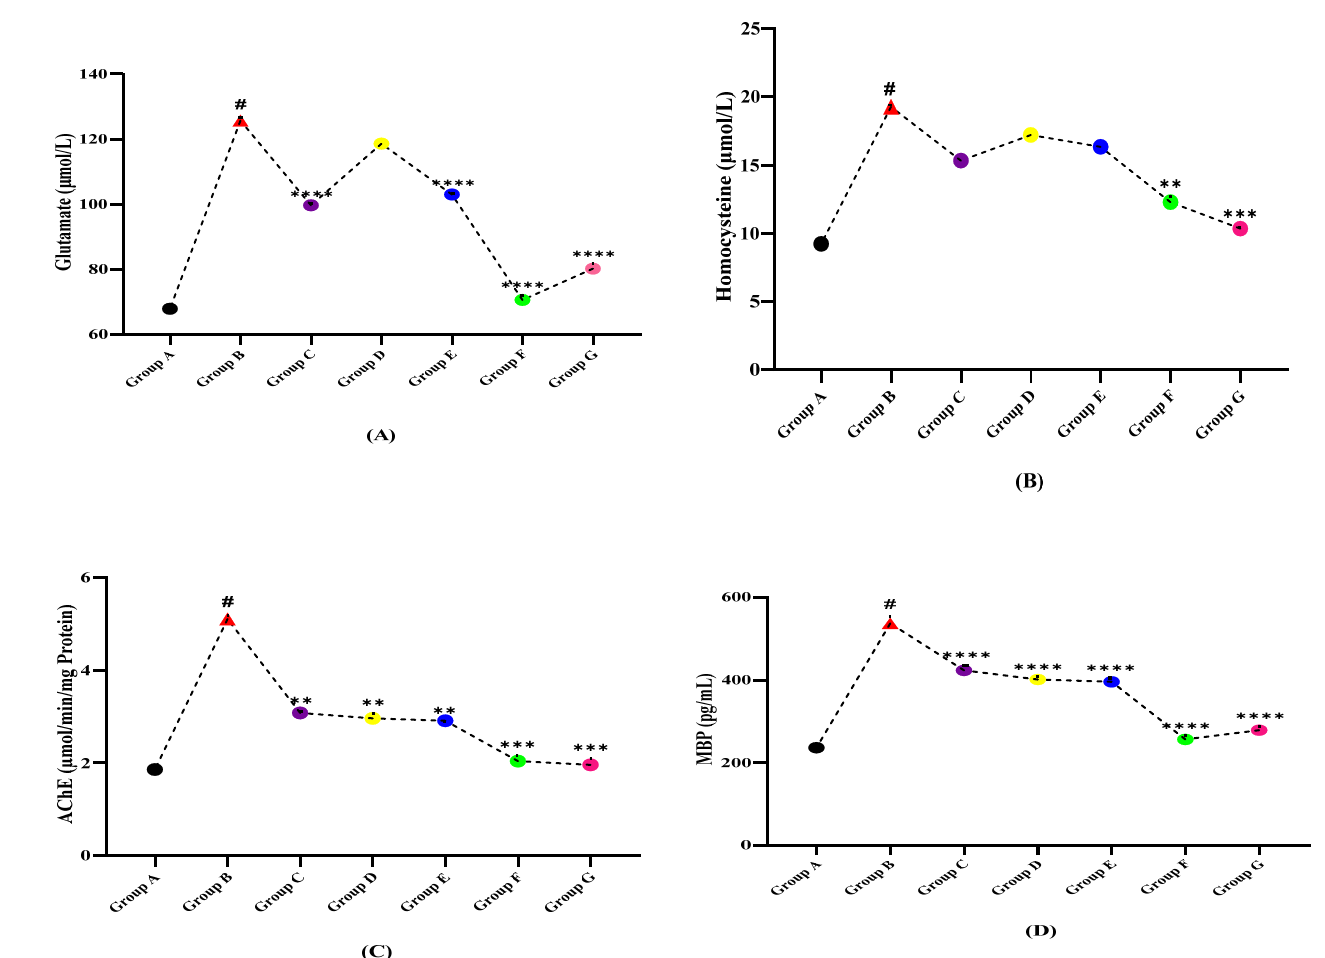
Figure 6. Comparison of plant extracts treated groups independently against LPS induced multiple sclerotic Wistar rats ( A ) glutamate, ( B ) homocysteine, ( C ) acetylcholinesterase (AChE), and ( D ) myelin binding protein (MBP). (# indicate reference group EAE model while Asterisks are showing the significance in the improvement of results as compared to reference group B). (*) slight significance, (**) moderate significance, (***) high significance, (****) very highly/effective significance.